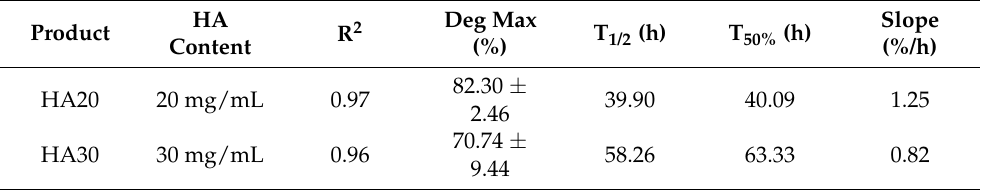
Figure 4. Trend of NAG released (%) in two different hydrogels containing different HA concentrations (20 or 30 mg/mL) after incubation with hyaluronidase at different timepoints (1/6/24/48/72/120/168 h). Data were plotted with the rectangular hyperbola equation as best ‐ fitting curve model.